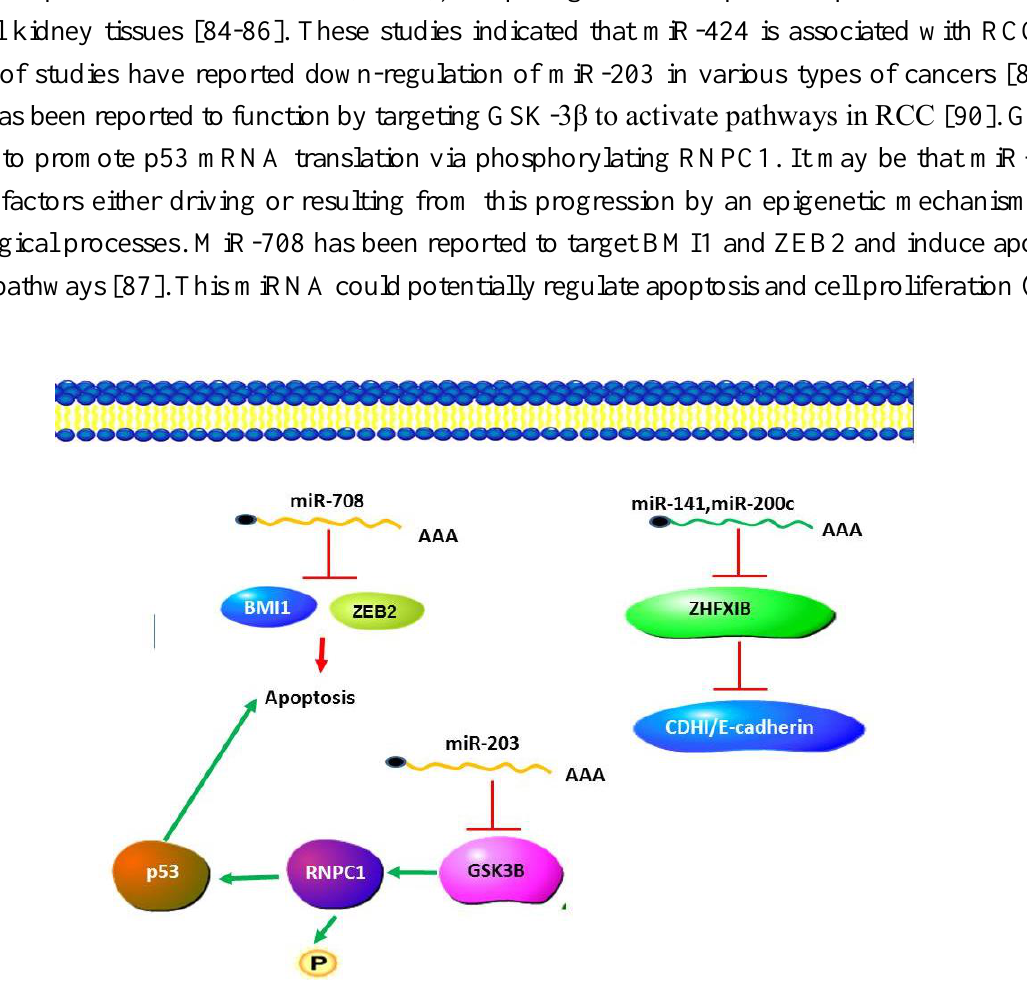
Figure 2. MicroRNA in Renal Cell Carcinoma (RCC). miR203 plays an anti-apoptotic